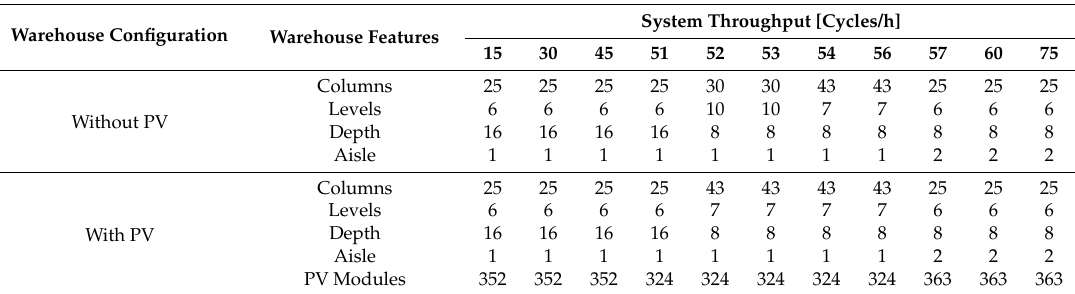
Table 5. R-AS/RS with PV plant: optimal rack configurations with minimum yearly total cost for different system throughputs.